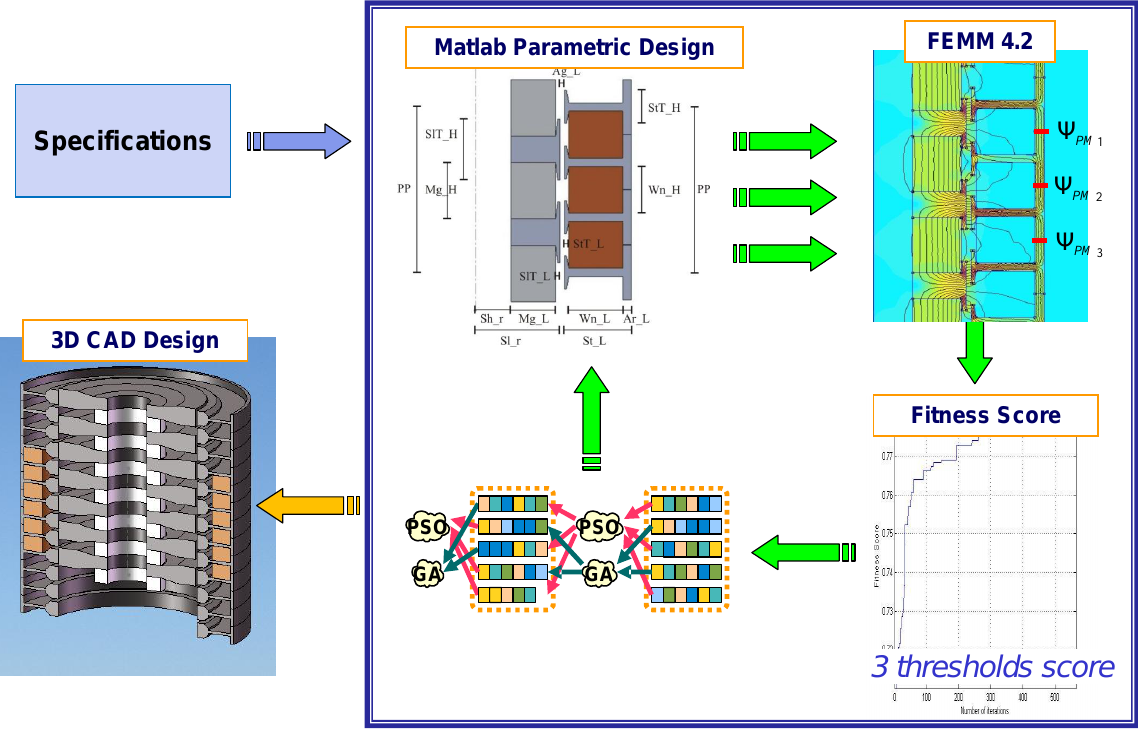
Figure 4. Flow chart of the design and optimization